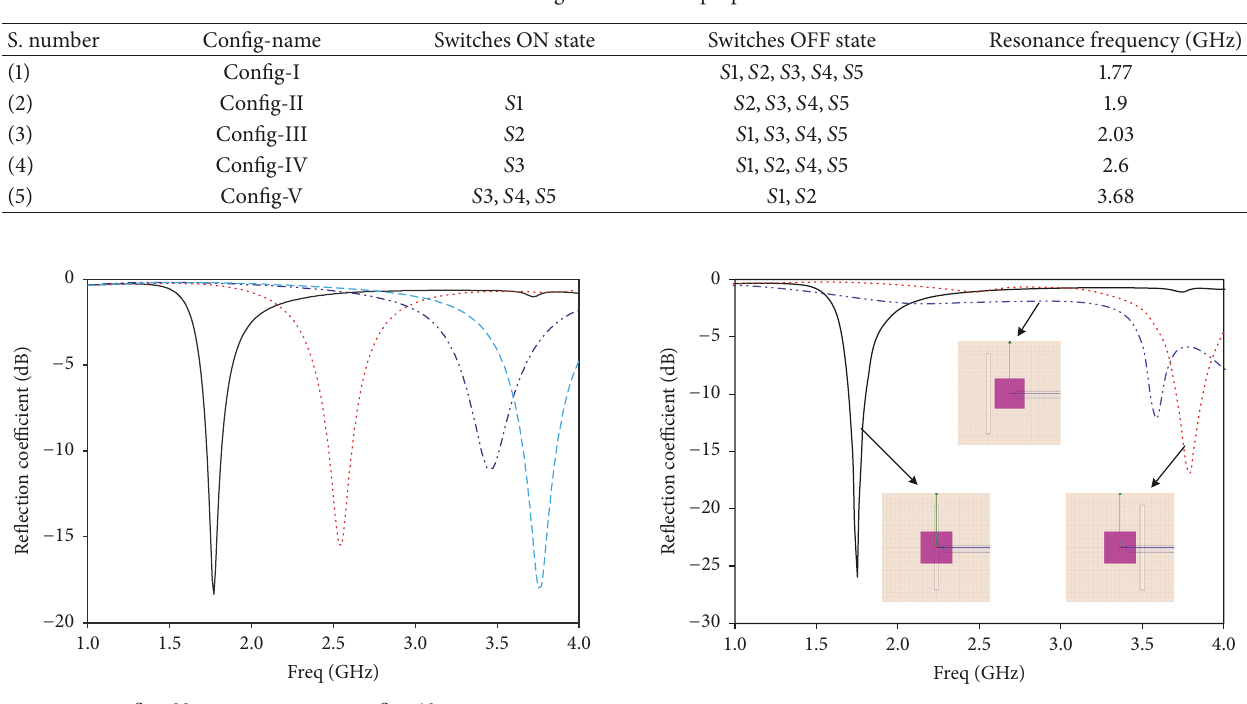
Figure 9: Resonance frequency variation for different slot positions.